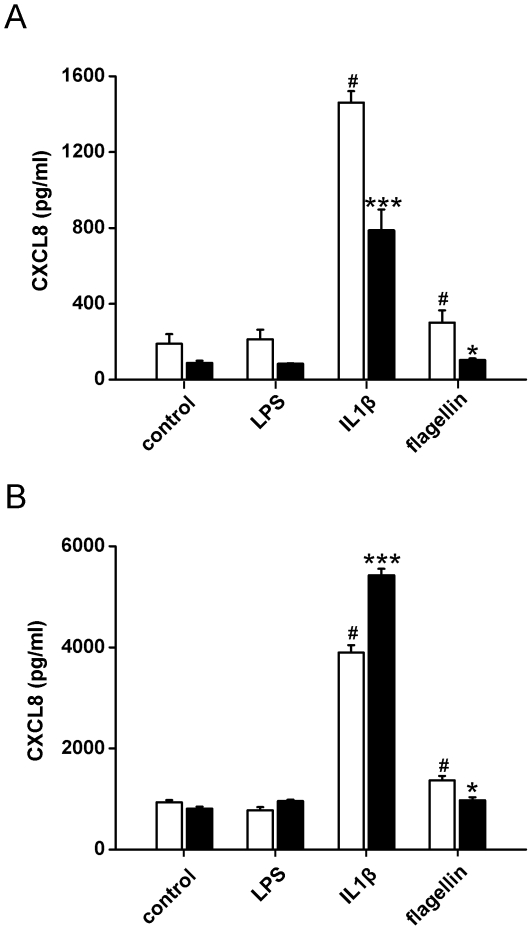
Enzyme-linked immunosorbent assay of CXCL8 production by hESC and purified hESC-derived endothelial cells.Bar graphs showing release of CXCL8 from 1 month-old differentiated H7 hESC cells (A) or hESC-derived CD31+ endothelial cells (B) transfected with scrambled siRNA (open bars) or TLR5 siRNA (solid bars) for 48 hours. Transfected cells were treated with TLR4 (LPS; 1 mg/ml), IL-1b (IL-1β; 1 ng/ml), or TLR5 (flagellin; 100 ng/ml) for 24 hours before CXCL8 was measured. The data are the mean ± S.E. mean for n = 3. # P<0.05 vs control; * P<0.05 and *** P<0.001 vs scrambled siRNA group.